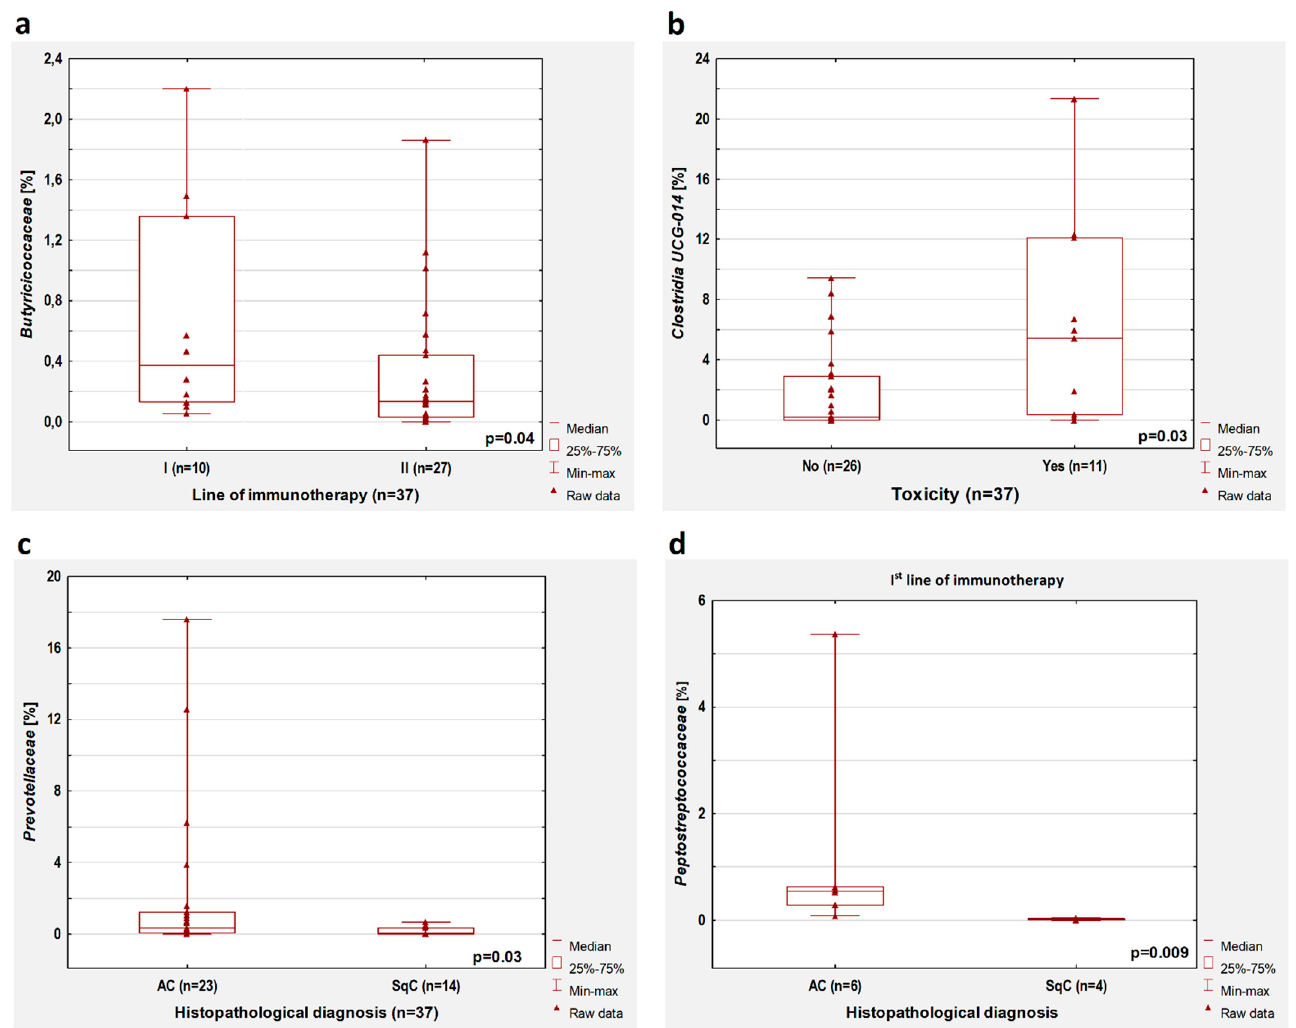
Figure 3. Boxplots showing the content of ( a ) Butiriciococcaceae depending on the line of immunotherapy; ( b ) Clostridia UCG-014 depending on immunotherapy toxicity; ( c ) Prevotellaceae depending on the histopathological diagnosis; ( d ) Peptostreptococcaceae depending on the histopathological diagnosis in patients who received first-line immunotherapy. All results concern the patients untreated with antibiotics before